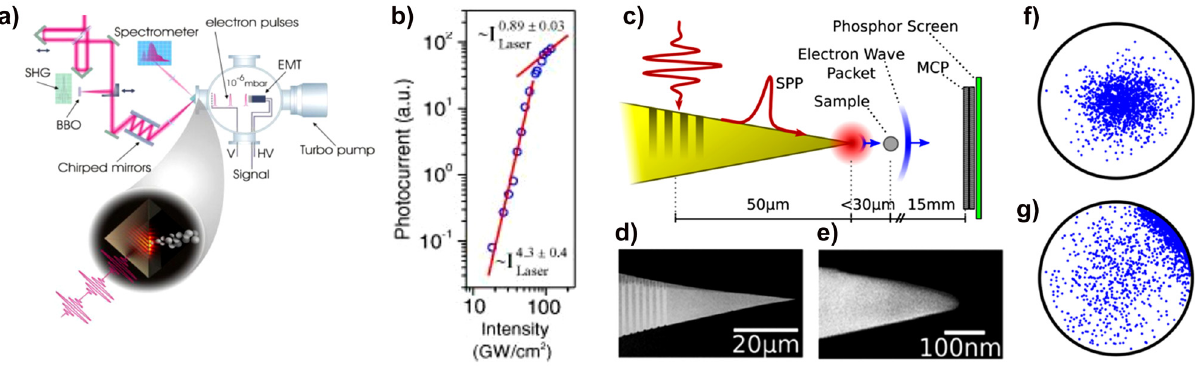
Figure 14: SPP-based photoelectron emission. (a) Schematic of a photoelectron emission experiment setup using the Kretschmann configuration. (b) Intensity dependence of the SPP enhanced photocurrent. Adapted with permission from ref. [189]. Copyright 2010, OSA.(c) Schematic of an electron emitted from a grating sharp nanotip. The illuminated grating generates an SPP, which propagates through the sharp nano taper apex and plasmonically enhances the photoelectron emission. The SEM image of (d) a grating sharp nano taper, (e) a magni fi ed image of a grating sharp nano taper. Spatial distribution of emitted photoelectron emission from (f) a grating sharp nano taper (radius 12 nm), (g) a blunt nano taper (radius 50 nm). Adapted with permission from ref. [190]. Copyright 2015,